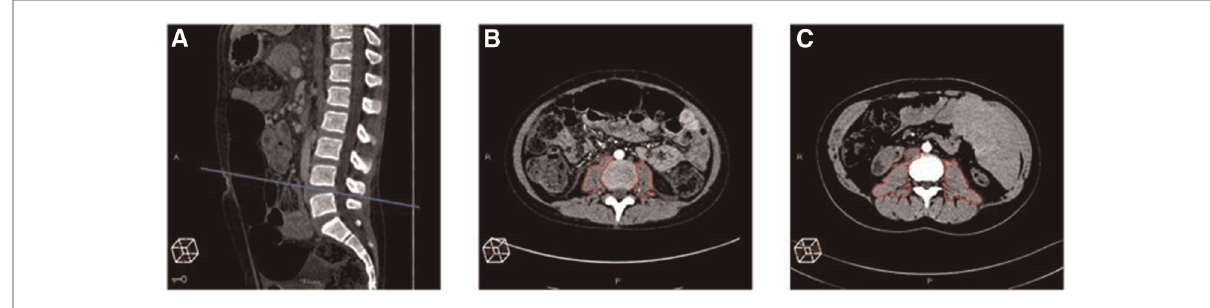
FIGURE 2 Measurement of the total psoas muscle surface area (t-PMSA). For the measurement of the total psoas muscle surface area (t-PMSA), the L4 – L5 level in the sagittal plane is identi fi ed ( A ) then the left and right psoas muscle areas are measured in the axial plane ( B,C ). ( B ) Shows the psoas muscles of a subject with sarcopenia t-PMSA: 981.6 mm 2 , z -score: − 2.88, while ( C ) those of a non-sarcopenic subject (t-PMSA: 2,390 mm 2 , z -score: